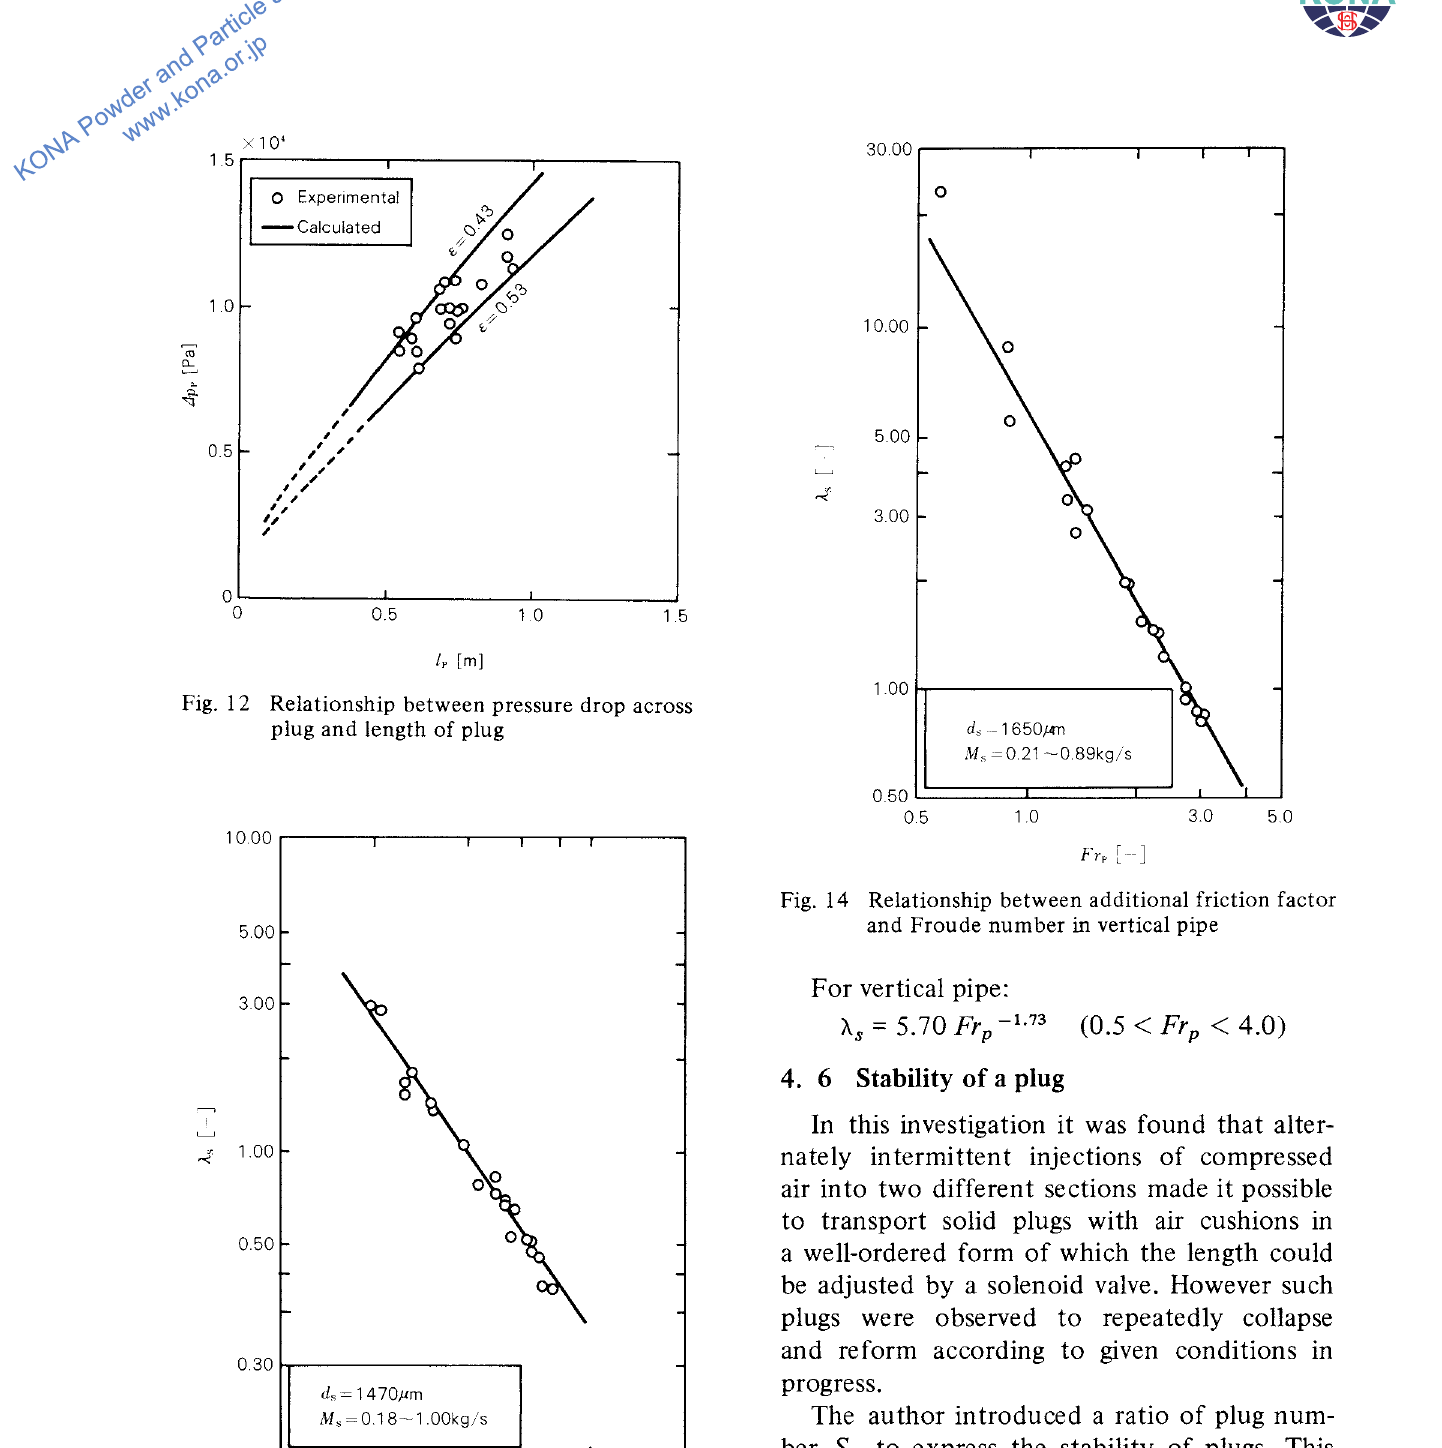
Fig. 13 Relationship between additional friction factor and Froude number in horizontal pipe